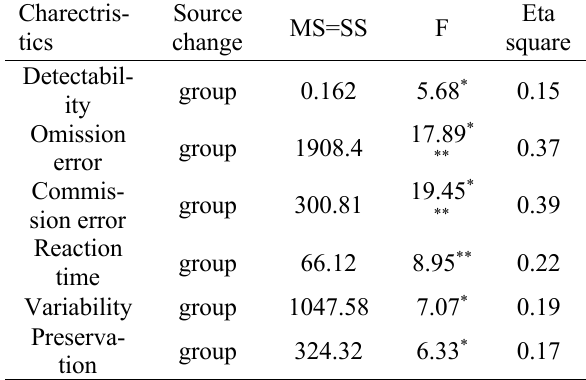
Table 6. Summary results of covariance analysis on the effects of education on improving the visual patterns of continuous performance test components boys with